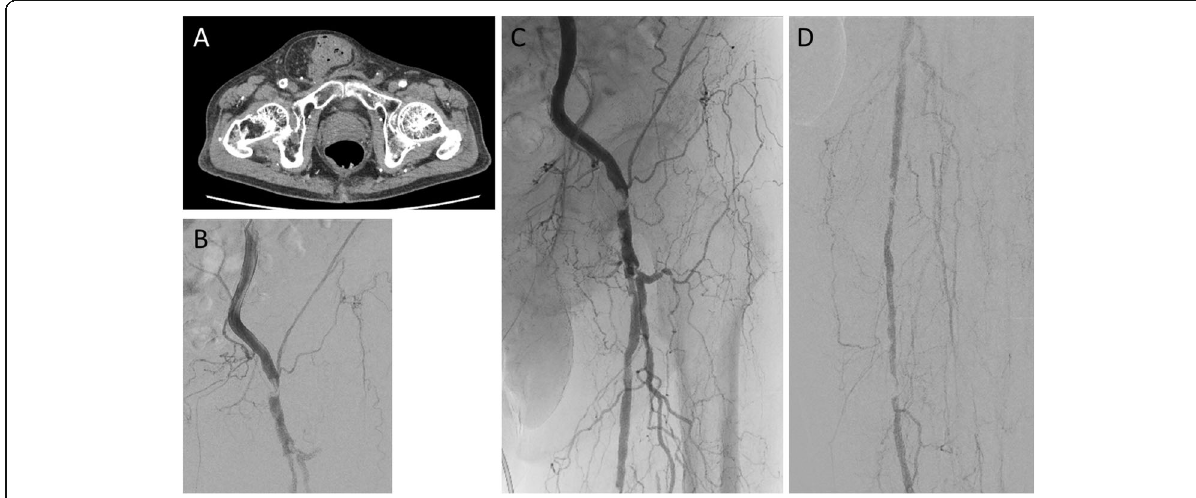
Fig. 1 a Plain computed tomography scan shows a calcified plaque in the left CFA. b – d Control angiography shows total occlusion of the left CFA with a calcified plaque and total occlusion of the middle to distal